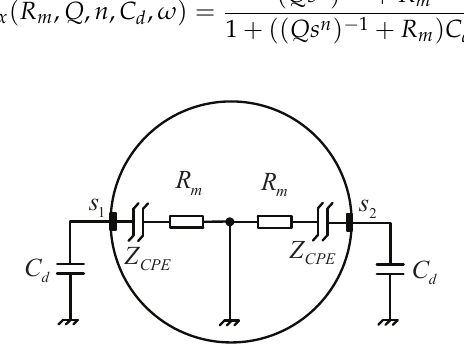
Figure 1. Equivalent circuit model of the transducer full of fluid.